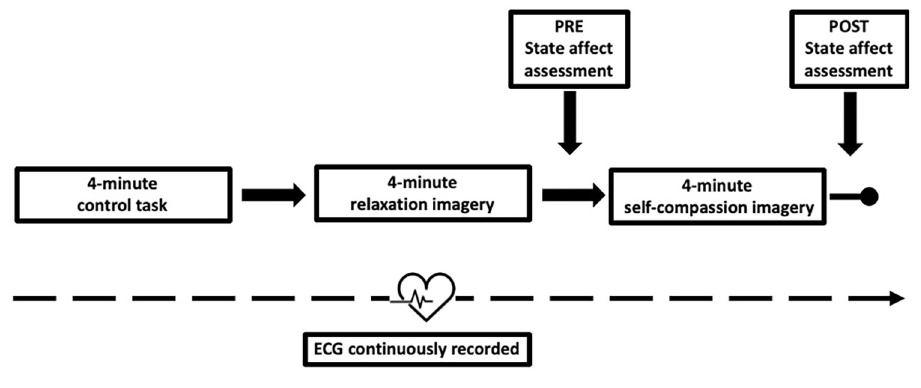
Fig 2. Outline of one experimental